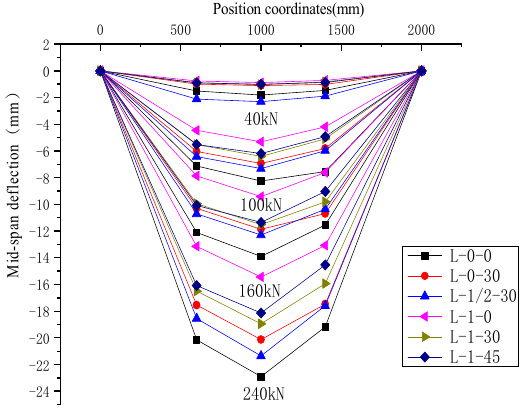
Figure 8. Comparison of test beam deformation under different loads.